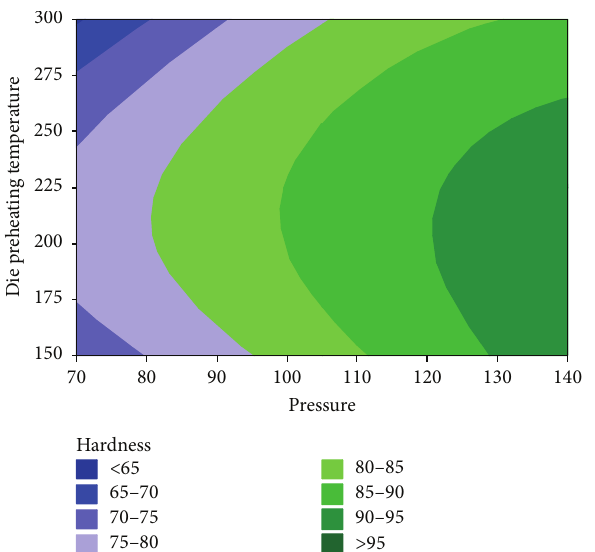
Figure 11: Main effect plots for YS.